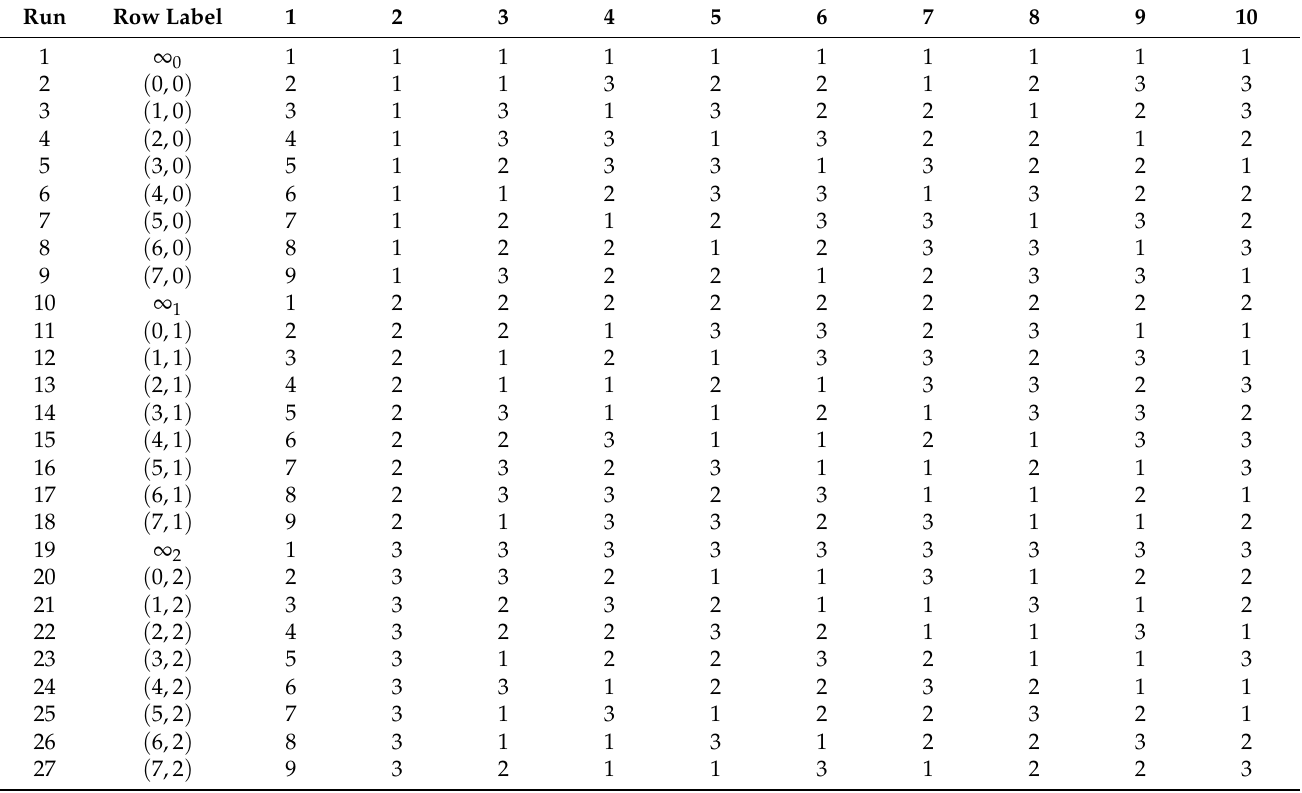
Table 1. A U-type design U ( 27;3 9 9 1 )